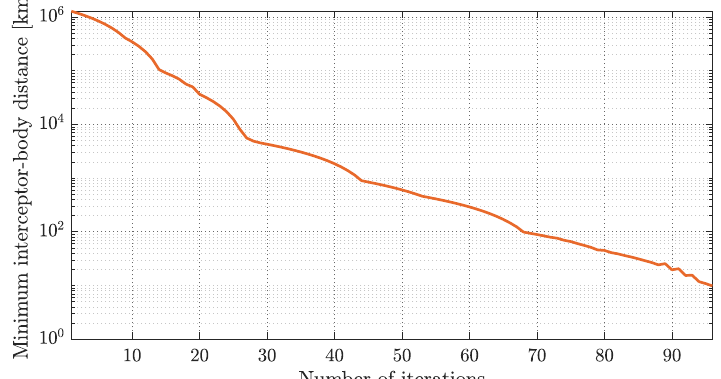
Figure 8. Evolution of the minimum interceptor-’Oumuamua distance, in km, with the impulse correction iterative